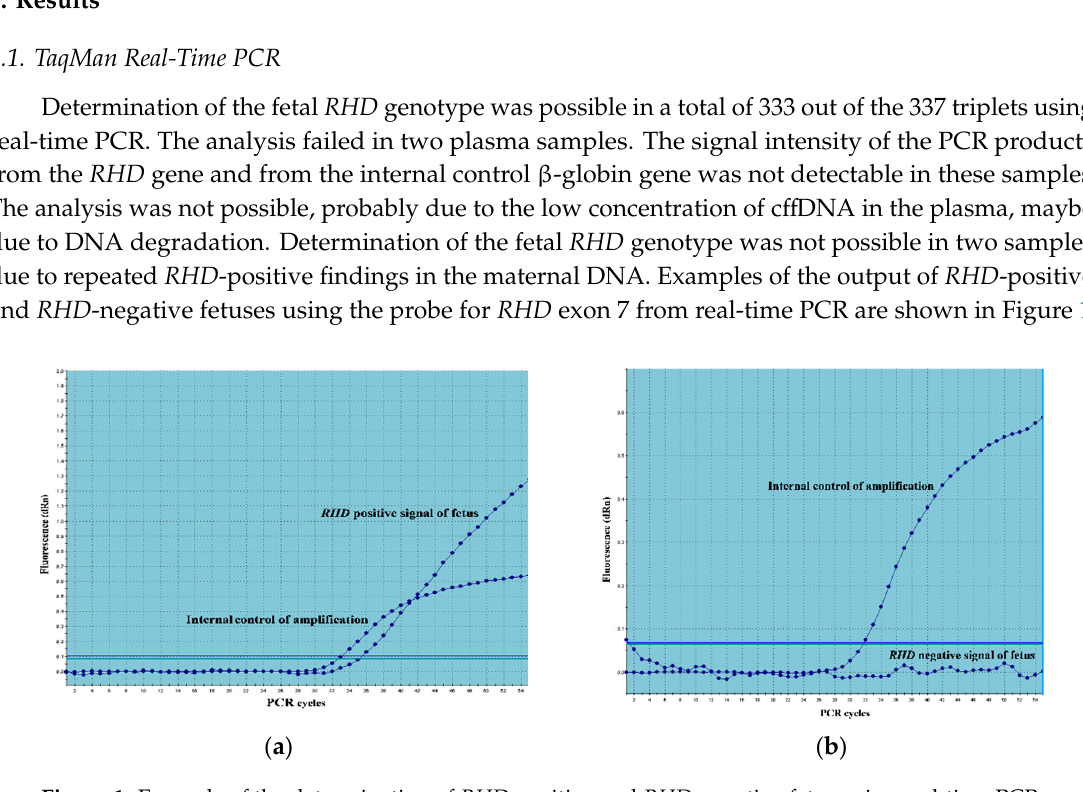
Figure 1. Example of the determination of RHD -positive and RHD -negative fetus using real-time PCR. Amplification curves show the fluorescence intensity of the probes as a function of the number of PCR cycles (Ct). ( a ) Example of an RHD -positive fetus: The RHD -positive signal of the fetus was detected by the probe for RHD exon 7. The internal control of the amplification was detected using a probe for β -globin. ( b ) Example of an RHD -negative fetus: No signal of an RHD exon 7 probe was detected. The internal control of the amplification was detected using a probe for β -globin.